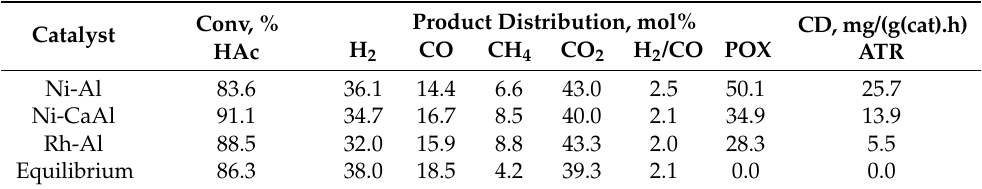
Table 3. HAc conversion, Products distribution, H 2 /CO and carbon deposition (CD) of the POX of HAc on fresh packed bed Ni and Rh catalysts. Acetic acid flow 1 mL/h, λ = 0.353 (Air flow = 22 mL/min), hot product gas at 570 ◦ C. CD from ATR at S/C 2 shown for